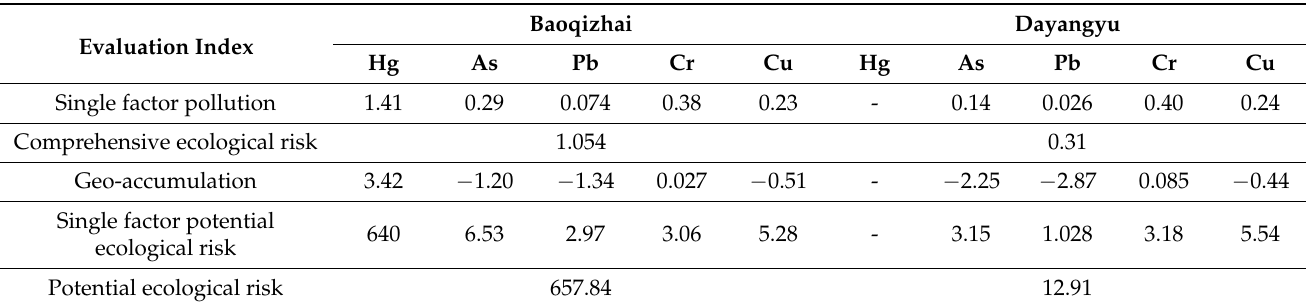
Table 5. Assessment results of heavy metal pollution